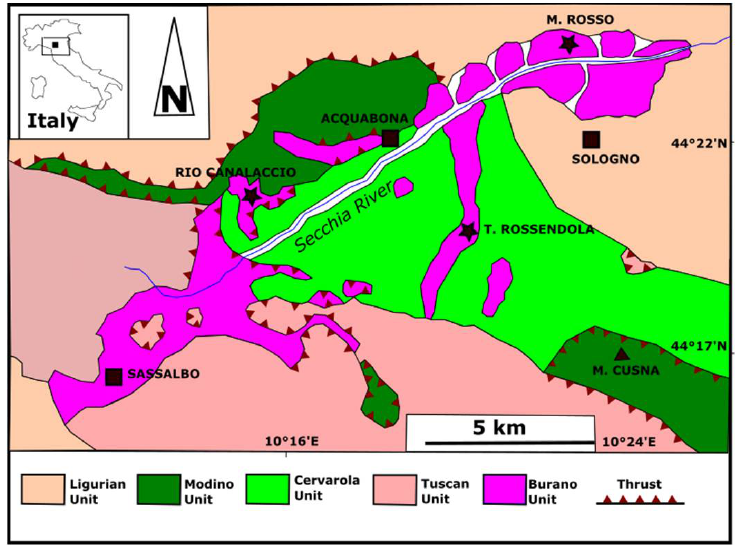
Figure 1. Simplified geological map of the upper Apennines of Reggio Emilia province with the Triassic Burano Formation; the black stars indicate the sites of the studied samples. Map redrawn from [13].